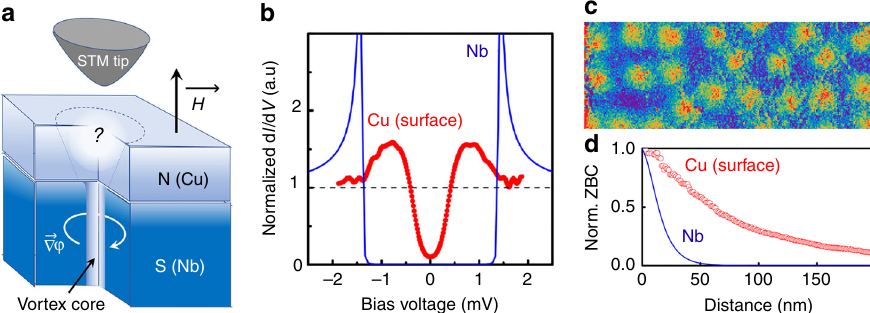
Fig. 1 Scanning tunneling spectroscopy experiment. a Local tunneling characteristics are probed at the surface of 50 nm thick Cu- fi lm backed with a 100 nm-thick Nb. Superconducting vortices are created in Nb by applying an external magnetic fi eld perpendicularly to Cu/Nb interface; b Red data points: tunneling conductance d I ( V )/d V spectrum measured at Cu-surface exhibits a minigap δ Cu ≃ 0.5 meV; it is three times smaller than the superconducting gap Δ Nb ≃ 1.4 meV in the d I ( V )/d V spectrum of Nb (blue line); the observed excitations inside the minigap are due to a non-zero residual magnetic fi eld (see the discussion in the main text); c 800nm × 250nm color-coded ZBC d I /d V ( V = 0) map acquired in the magnetic fi eld of 120 mT reveals proximity vortices; d Radial variation of the ZBC from the vortex center de fi nes the vortex core pro fi le (red data points). The minigap vanishes in the vortex cores; blue line-expected radial ZBC evolution at the Abrikosov vortex core in Nb- fi